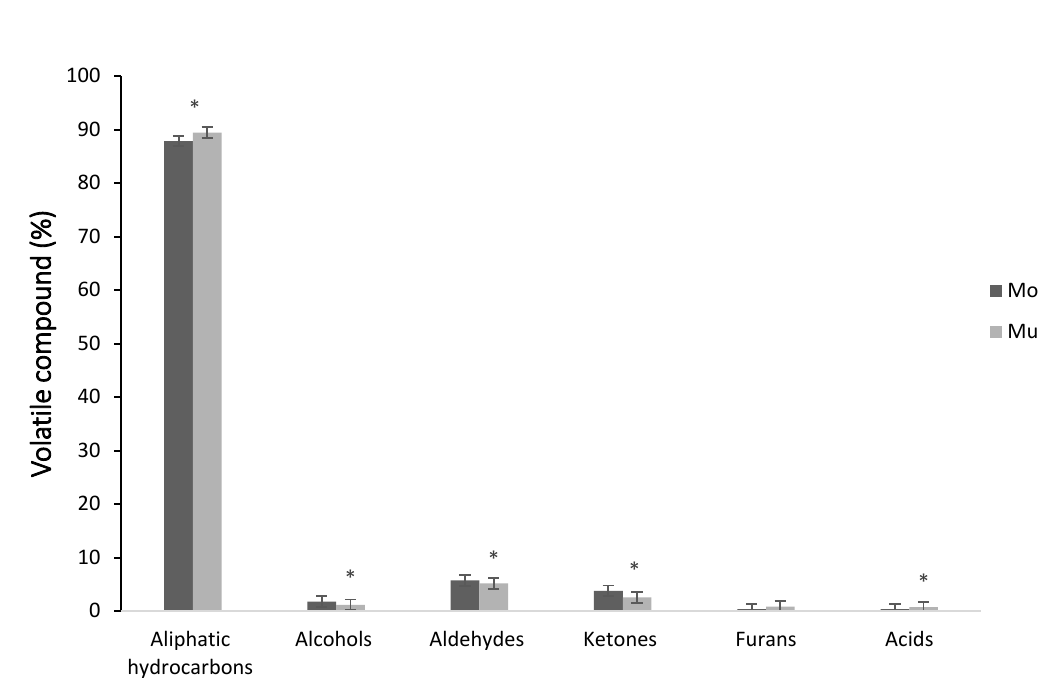
Figure 1. Volatile compounds of monolayered (Mo) and multilayered (Mu) fish oil microcapsules classified according to chemical families. Values are expressed as the average percentage of each family. *: significant differences ( p < 0.05).